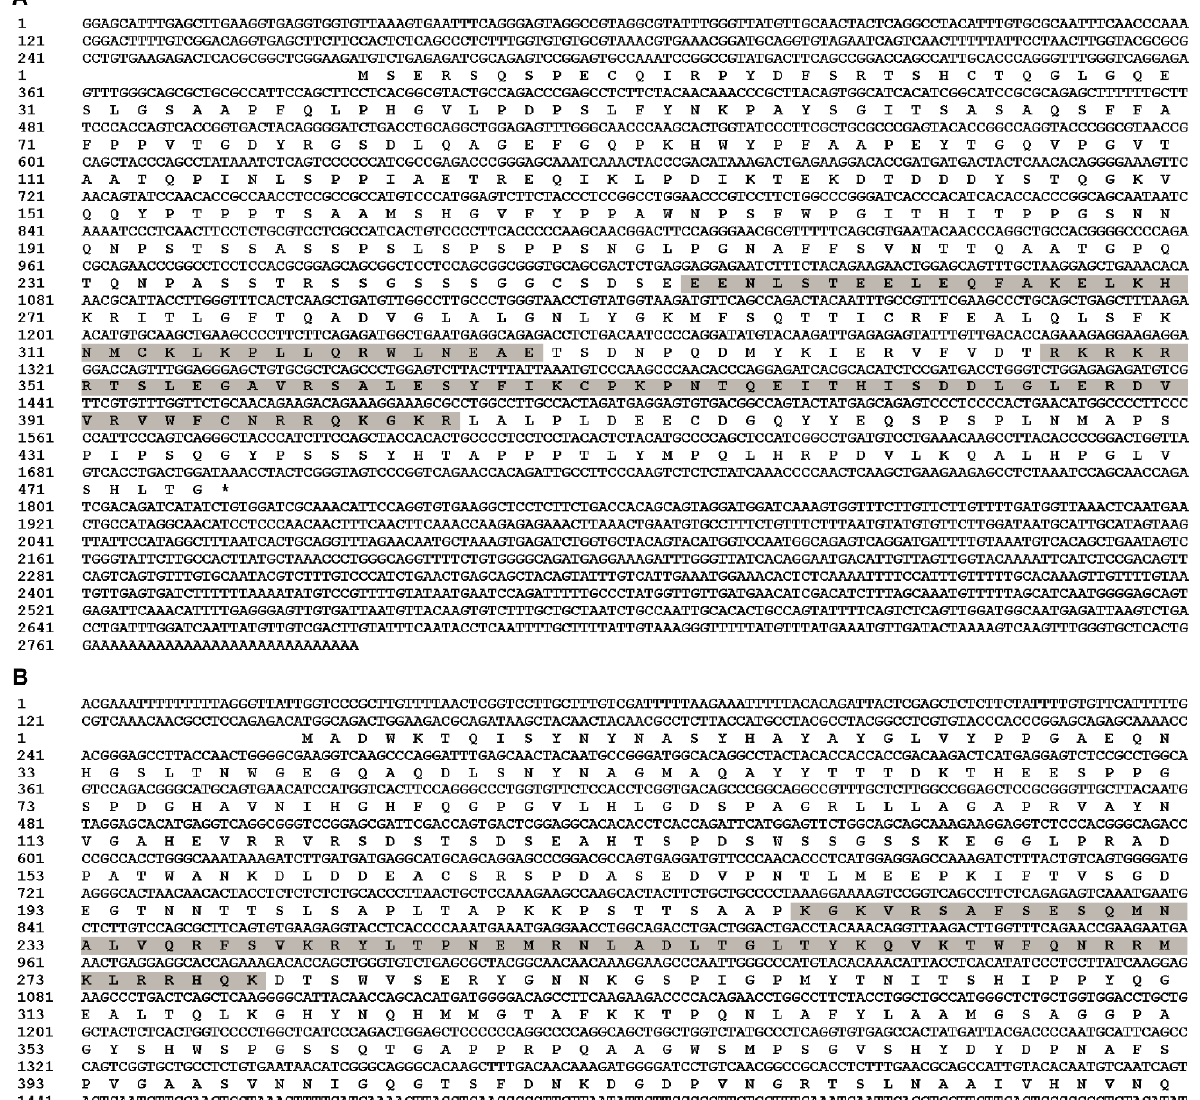
Figure 1. Full-length cDNA sequences and predicted polypeptides of ( A ) EcPou5f1 and ( B ) EcNanog . Gray shadow: POUs and POUhD in ( A ), and HD in ( B ). Stop codon is labeled with an asterisk (*).